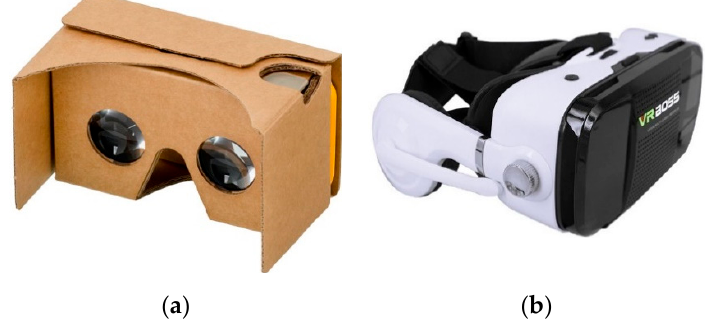
Figure 1. Example of Virtual Reality headsets. ( a ) Google Cardboard. ( b ) VR BOSS Z5.